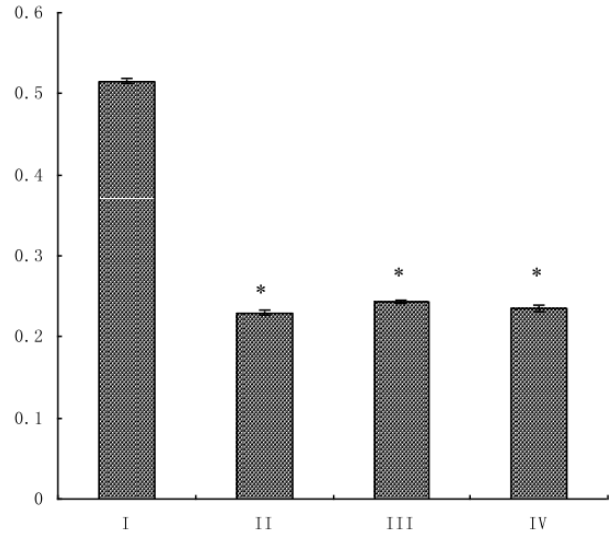
Figure 1. Proliferation of HSC-T6 cells (hepatic stellate cells) treated with a combination of taurine, epigallocatechin gallate (EGCG) and genistein. HSC-T6 cell proliferation was measured by MTT assay. The effect of varying doses of taurine, EGCG and genistein were compared to (I) untreated control cells; or cells treated with (II) 0.015 mg/mL taurine, 0.0175 mg/mL EGCG and 0.0035 mg/mL genistein; (III) 0.03 mg/mL taurine, 0.035 mg/mL EGCG and 0.007 mg/mL genistein; or (IV) 0.06 mg/mL taurine, 0.07 mg/mL EGCG and 0.014 mg/mL genistein. Data are presented as the mean ± S.E.; * p <0.05 vs. group I (untreated control).